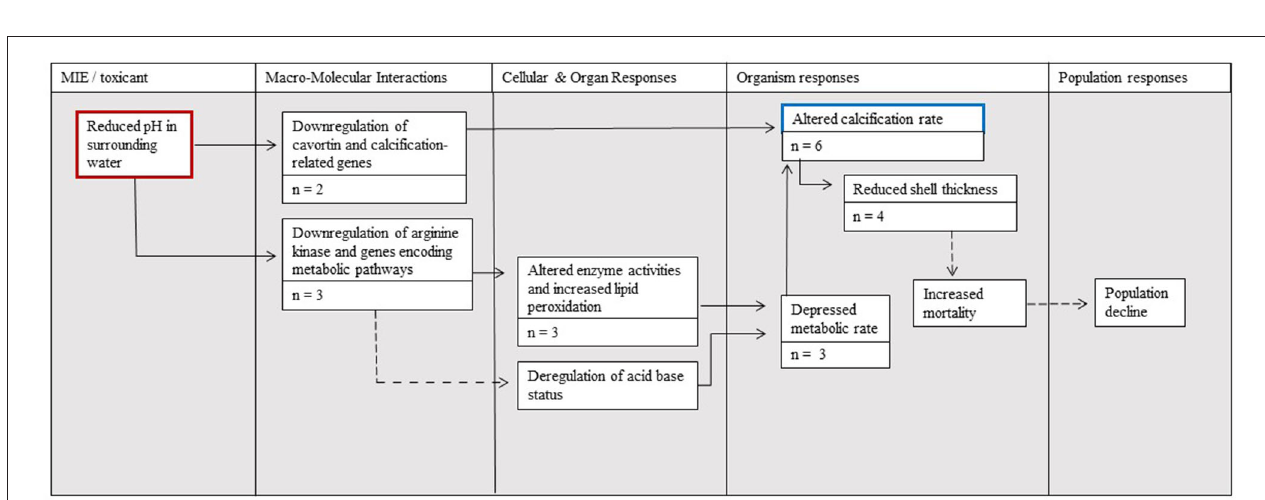
FIGURE 4 | The Adverse Outcome Pathway (AOP) linking the effects of ocean acidification (red border) to calcification (blue border) and its effects on Magallana gigas as supported by the studies assembled in the present meta-analysis. The number of studies supporting each step is denoted by n = X. Solid arrow lines represent established linkages with quantitative data documented for M. gigas , whereas dotted arrow lines represent linkages supported with data considering other bivalves.